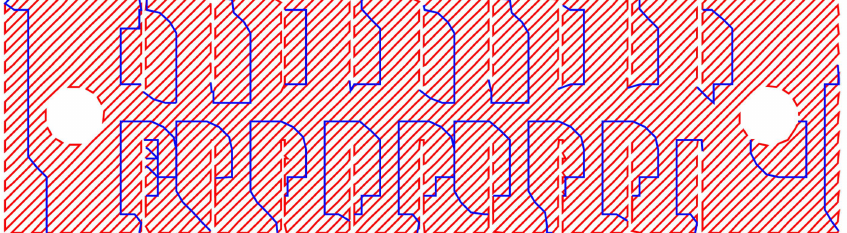
Figure 5. Digital representation of the embroidered textile strain sensor. The red lines represent the running stitch direction and the blue lines show the underpath that will be followed by the needle when embroidering. Changes in resistance happen when the running stitch contacts the